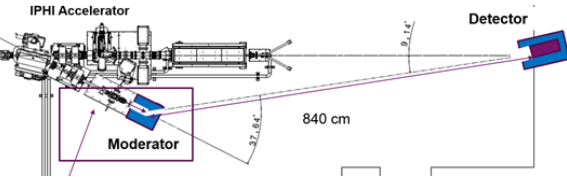
Fig. 1. Sketch of the experimental set-up. The target is installed on a deviator line and the neutron detectors are set at 8.4m from the target so as to be able to perform time-of-flight measurements.